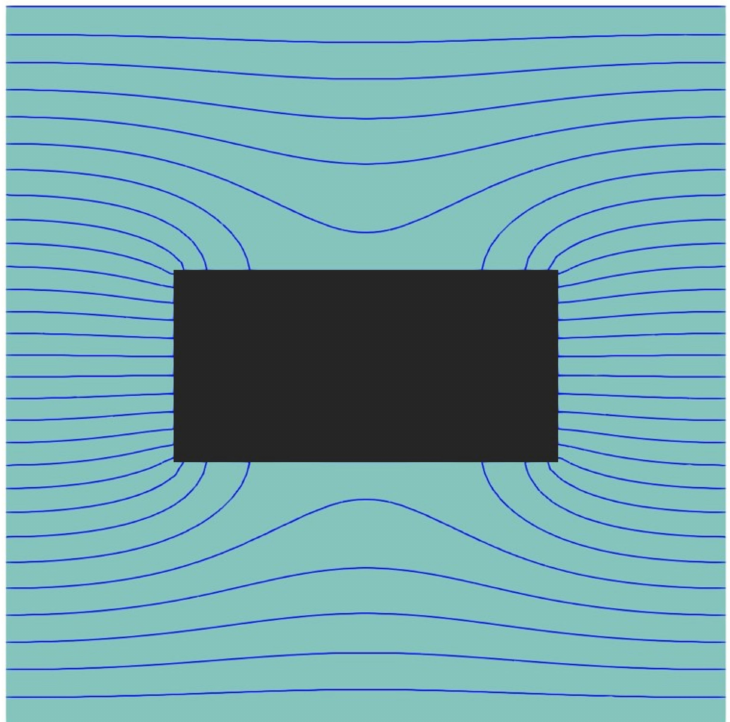
Figure 7. The steady-state isoconcentration lines of the migrating species on the half-cut plane of an elementary unit of a MMM with a cuboid nanoparticle with an aspect ratio q = 2.07 and a relative thickness y p / L y = 0.25.